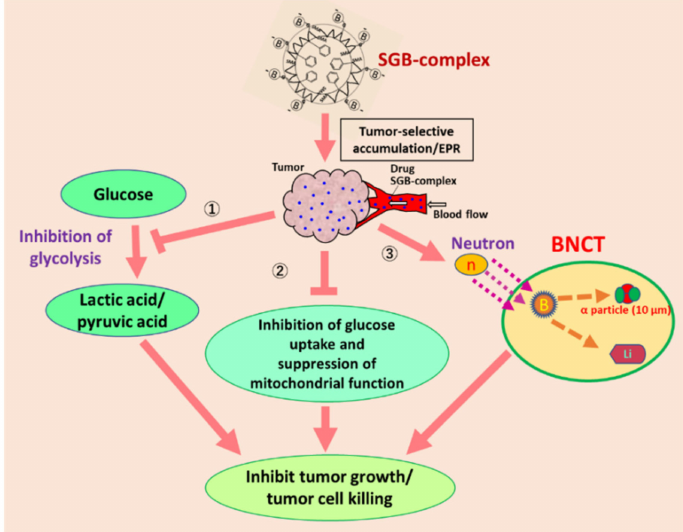
Figure 6. This represents the mode of action of poly(styrene-co-maleic acid) conjugated glucosamine (SGB-complex), which forms complex with boric acid, then forms micelles (~15 nm) and exhibits the EPR effect, about 10 times more boron accumulation in the tumor than other normal tissue [67]. When this SGB-complex is used, it exhibits three different cell killing mechanisms as denoted by “ 1 (cid:13) , 2 (cid:13) , and 3 (cid:13) ” in this figure. By neutron irradiation at right, 3 (cid:13) , it elicits the production of α -particles which will kill the tumor cells within 10 micron radius. SGB-complex is rapidly incorporated into the tumor cells and inhibit both glycolysis 1 (cid:13) and production of lactic acid; 2 (cid:13) it also affects the structural integrity of mitochondria, and its size will shrink and suppress ATP production in the cells (Reprinted with permission from ref. [67]. 2020 Elsevier Ltd.).